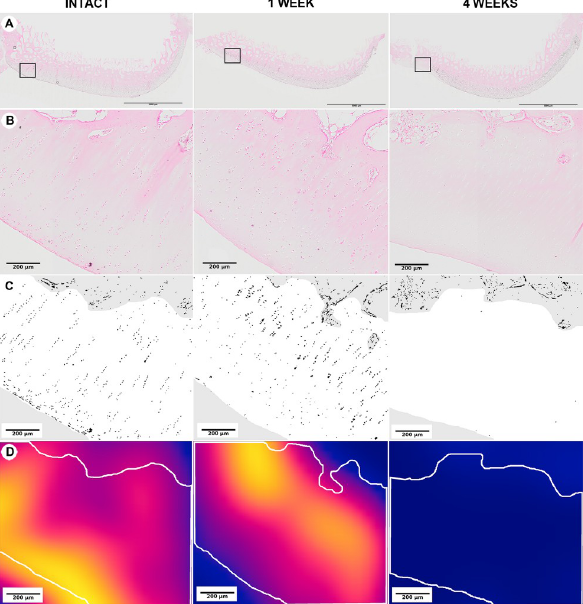
Fig 4. Medial femoral condyle articular cartilage irreversible cell injury and loss at 1- and 4 weeks following surgical induction of PTOA. The magnifications shown in this figure were selected for illustrative purposes; all analyses were performed using a 20x objective. All sections are in the frontal plane and the area adjacent to the intercondylar notch is to the left of each figure. (Row A) Low magnification, H&E. Boxes indicate regions shown at higher magnification in Row B. (Row B) Higher magnification, H&E. Note the changes in chondrocyte distribution in areas articulating with the tibial spine at 1- and 4 weeks post-surgery. (Row C) Pseudocolored images of the lateral half of the areas in Row B highlighting the nuclei detected through image processing in black. (Row D) Heatmaps of chondrocyte cell density for the areas in Row C ranging from yellow–highest cell density, to red–intermediate cell density, to dark blue–no cell density. Note the loss of viable chondrocytes in this region for the 4-week